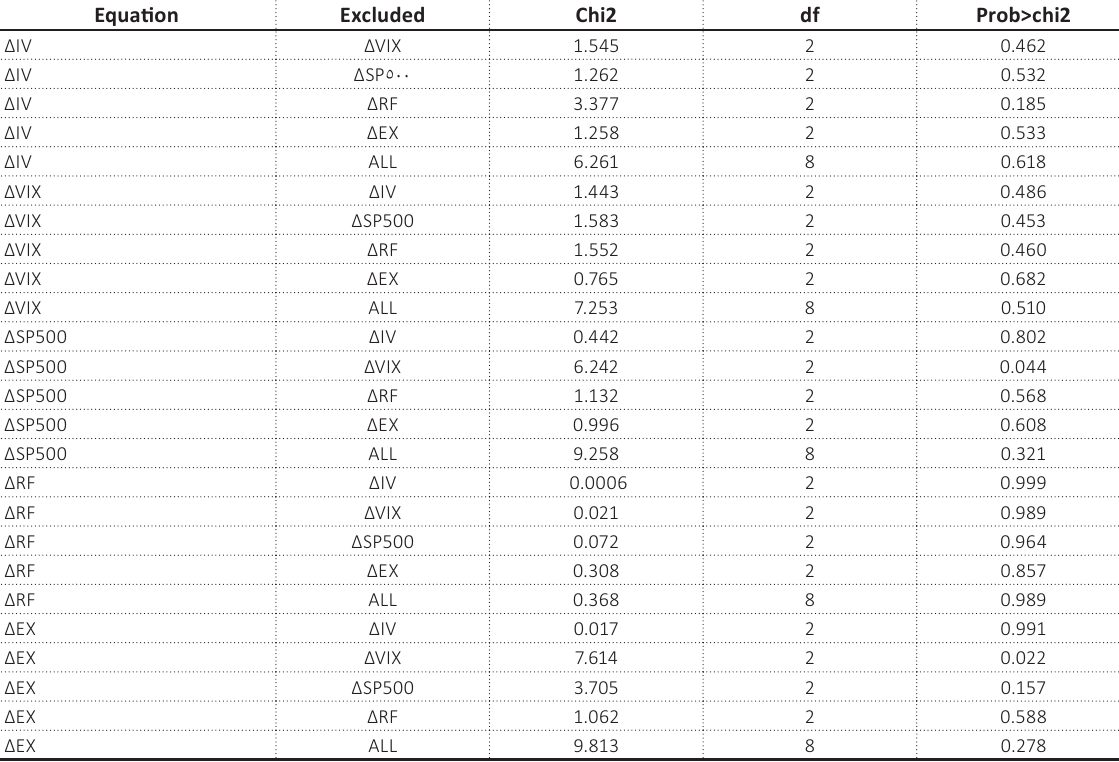
Table 1. Granger causality Wald